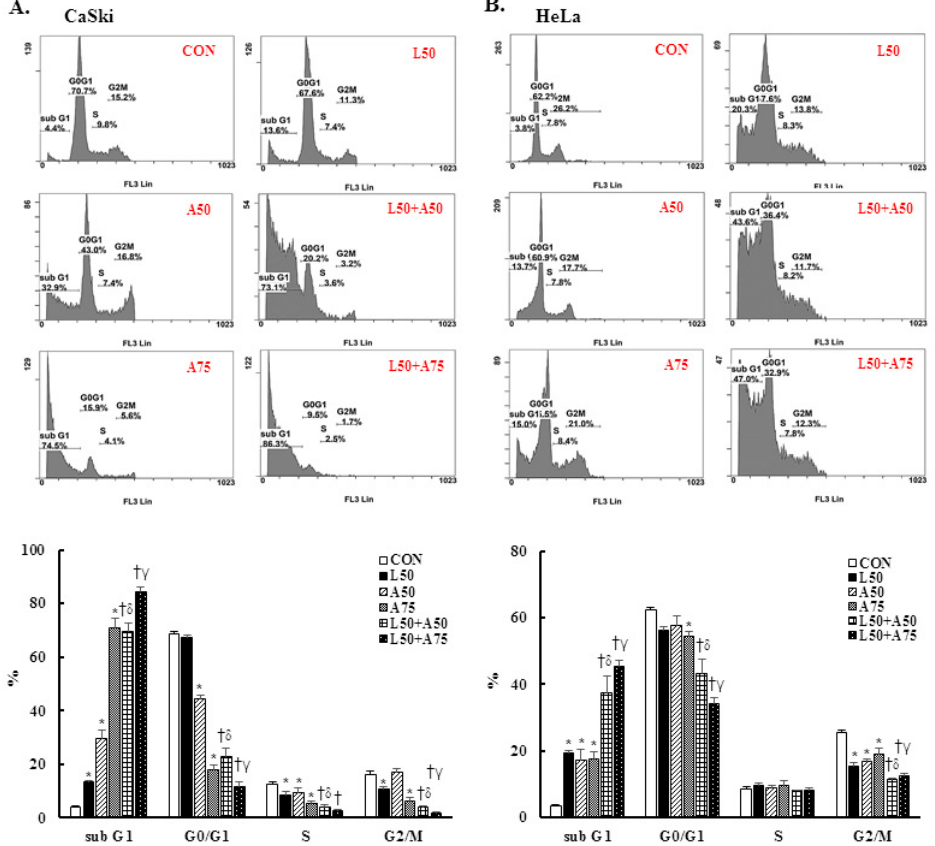
Figure 3. The combination of luteolin and asiatic acid led to cell cycle arrest in the sub-G1 phase in CaSki and HeLa cells. CaSki and HeLa cells were analyzed using flow cytometry after 24 h of treatment with Lut (50 µ M) or AsA (50 and 75 µ M) alone or in combination. Representative flow cytometry results (upper panel) and histograms (lower panel) reveal the cell cycle distribution (sub-G1, G0/G1, S and G2/M) and quantitative analysis for ( A ) CaSki and ( B ) HeLa cells. Values represent mean ± SD from three replicates. *, †, δ and γ p < 0.05 compared with CON, L50-, A50- or A75-treated group. CON, 0.1% DMSO; L50, 50 µ M luteolin; A50, 50 µ M asiatic acid; A75, 75 µ M asiatic acid. L50 + A50, 50 µ M luteolin + 50 µ M asiatic acid; L50 + A75, 50 µ M luteolin + 75 µ M asiatic acid.